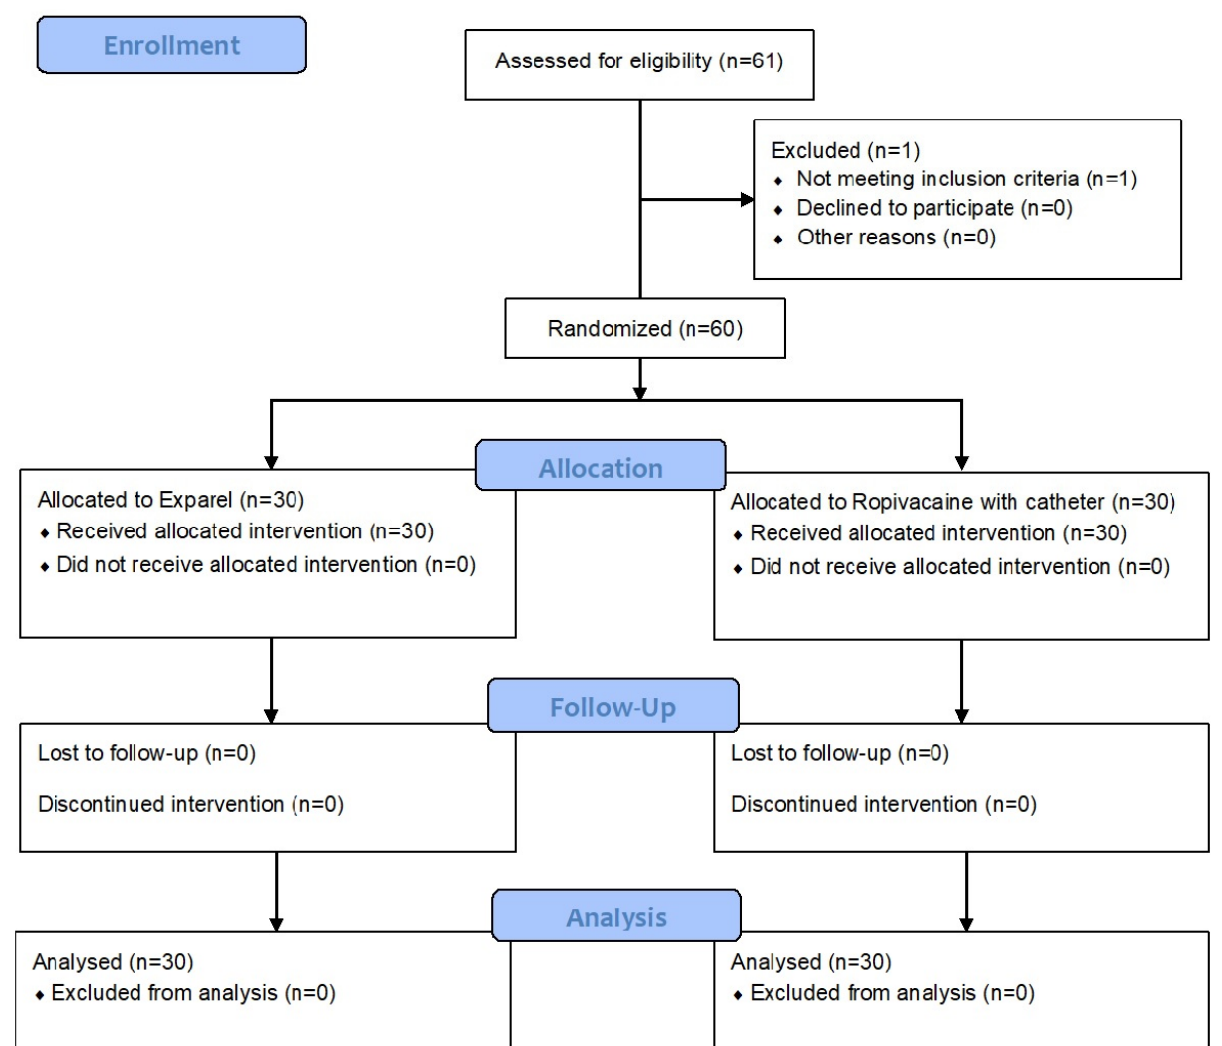
Figure 1. Flow chart demonstrating study design. Table 1. Characteristics of the two patient groups.